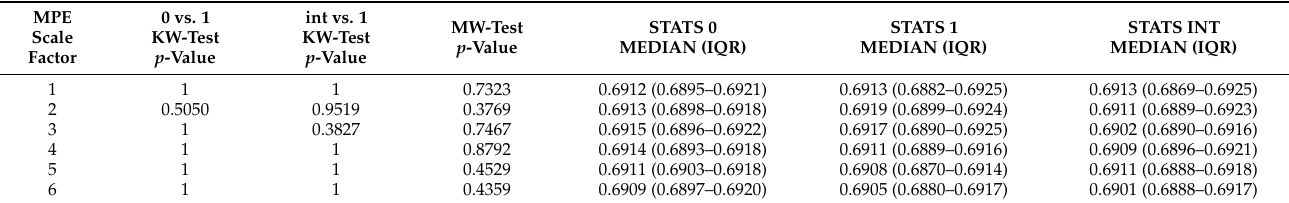
Table 5. Multiscale Permutation Entropy—statistical results of the test described in Section 2.6. All tests were performed on 33 patients with seizures vs. 19 seizure-free patients. The descriptive statistics (median and IQR) related to the three groups considered (0, 1, and int) are reported.